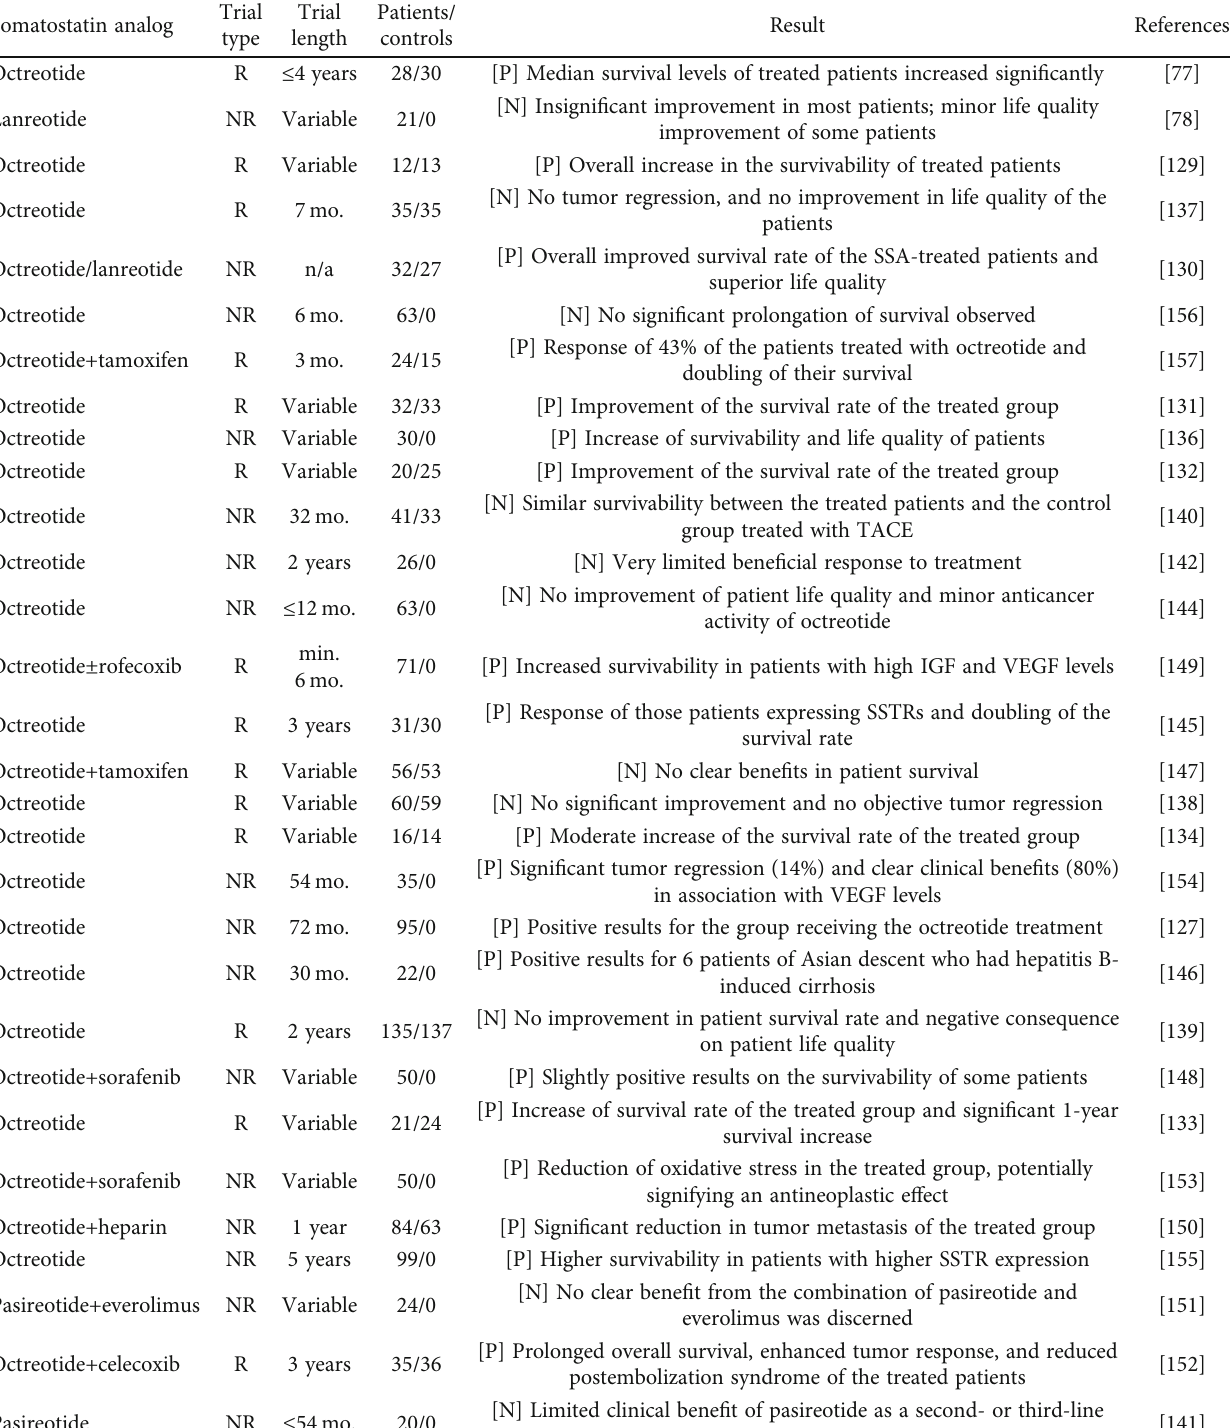
Table 4: Clinical trials evaluating the role of SSAs in the treatment of